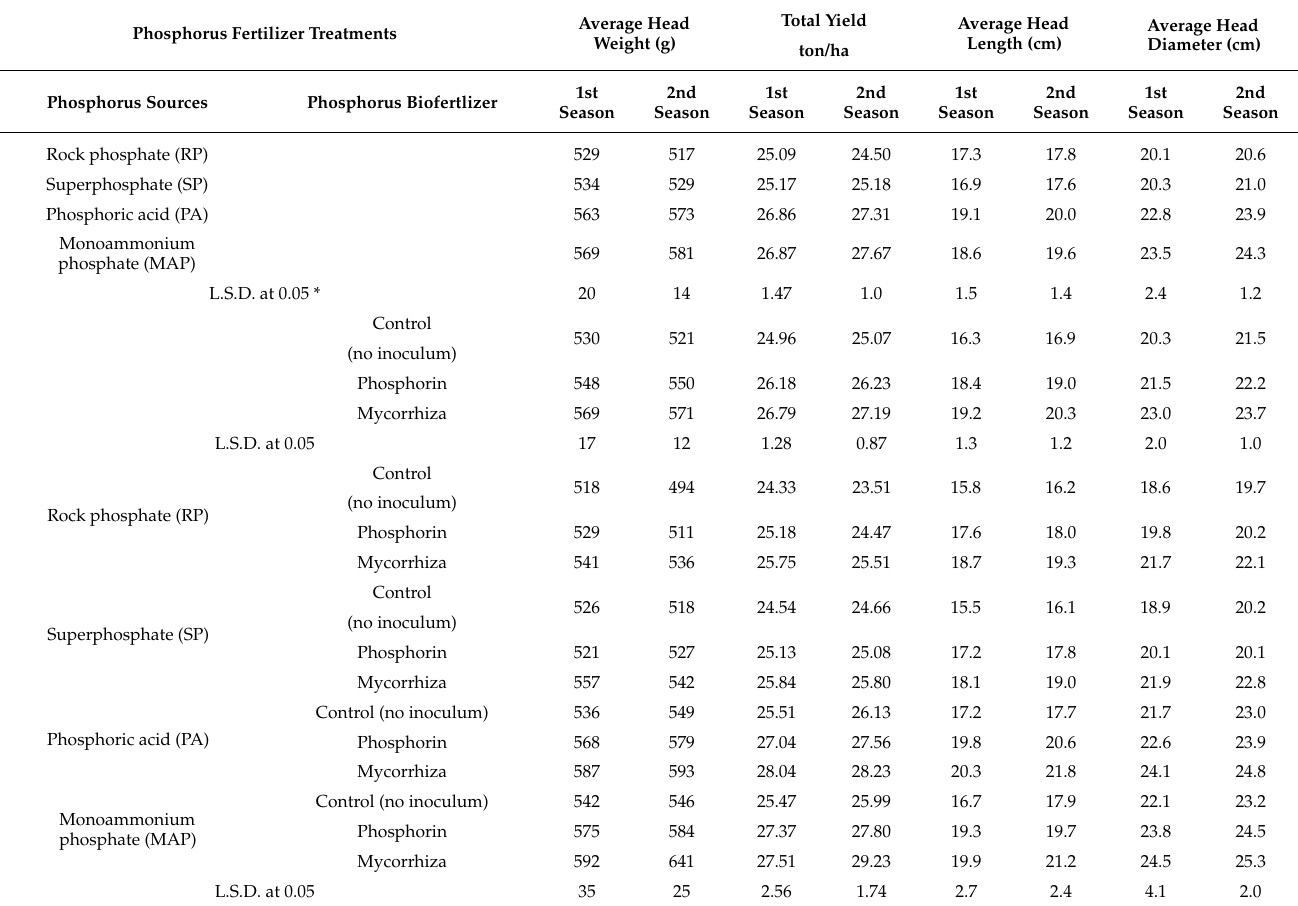
Table 6. The effect of phosphorus sources and bio-fertilizers application on yield parameters of broccoli plants during the 2018 (1st) and 2019 (2nd)